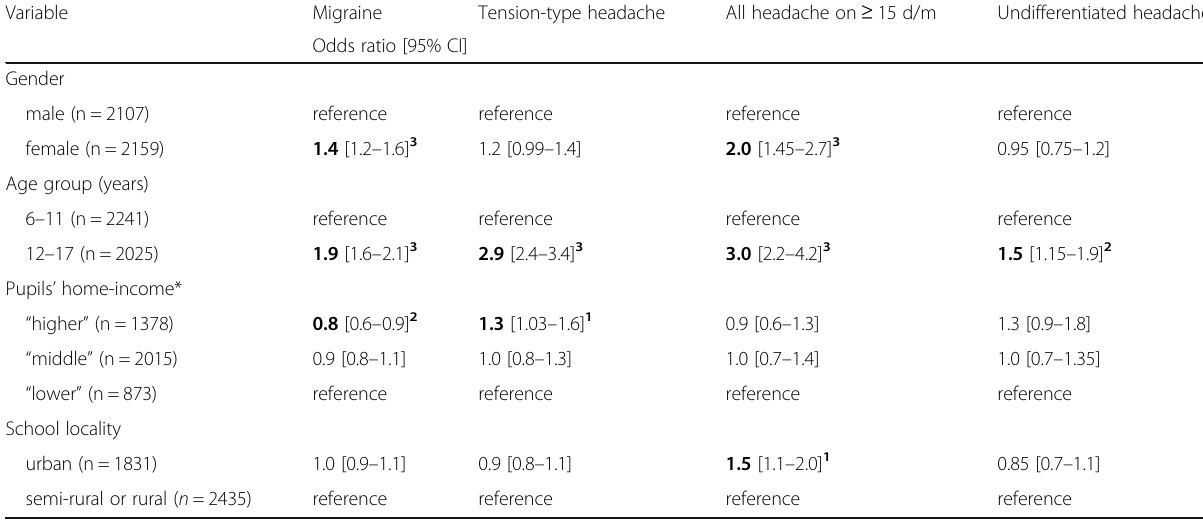
Table 3 Bivariate analyses of associations of headache types with demographic variables ( N = 4266)